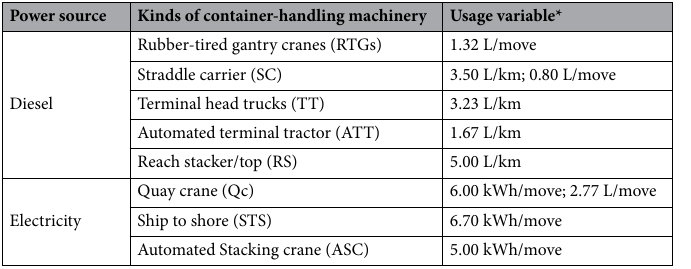
Table 1. Energy consumption patterns of each container-handling equipments. *This variable was estimated according to previous research 24,41,42